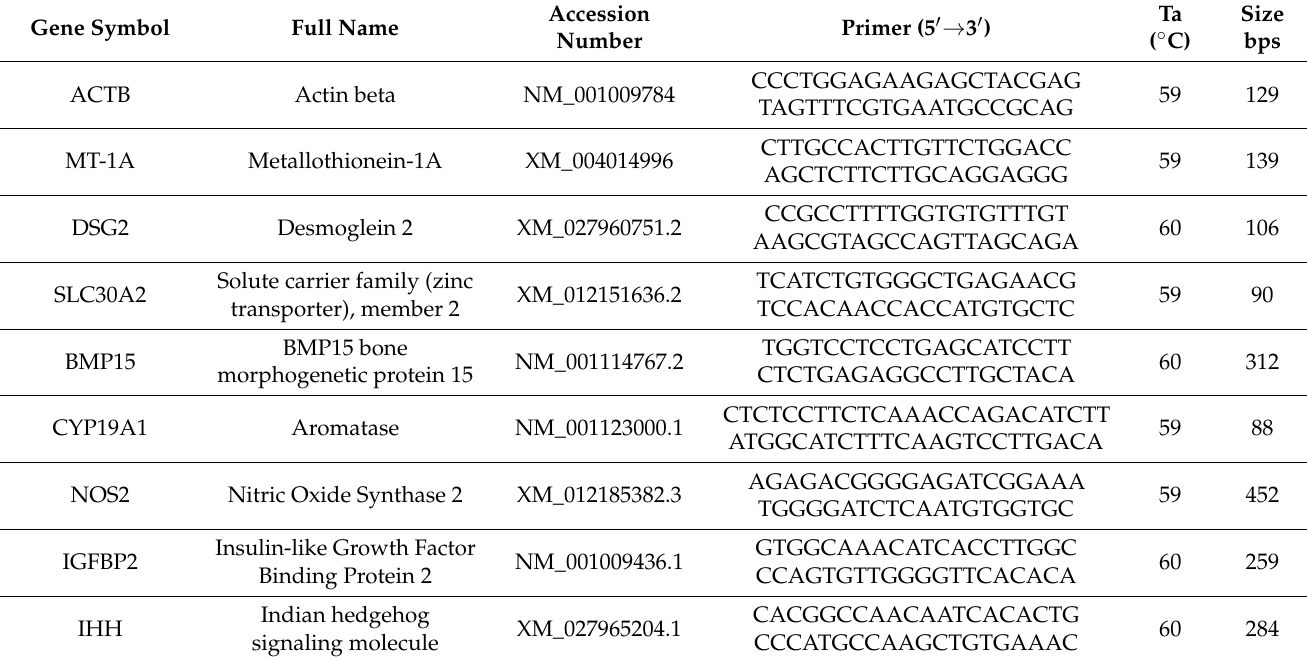
Table 1. Primer pair sequences used for Real-Time